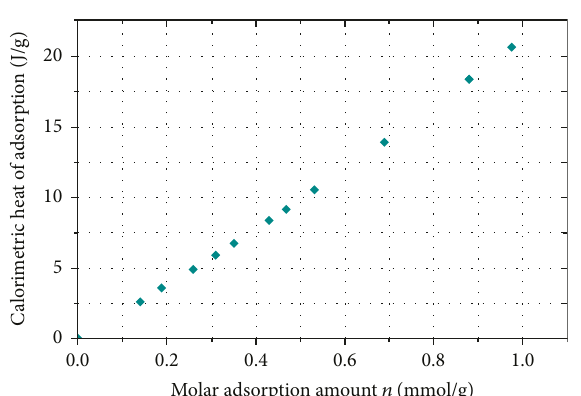
Figure 5: Calorimetric heat of adsorption for methane measured by C80 microcalorimeter.